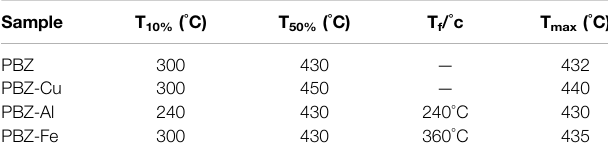
TABLE 5 | Thermal properties of PBZ, PBZ-Cu, PBZ-Al, and PBZ-Fe. Sample